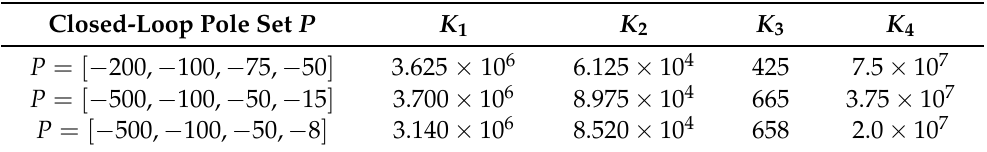
Table 7. Nonlinear continuous-time controller parameters for the prescribed closed-loop poles determined for a linearized system (feedback